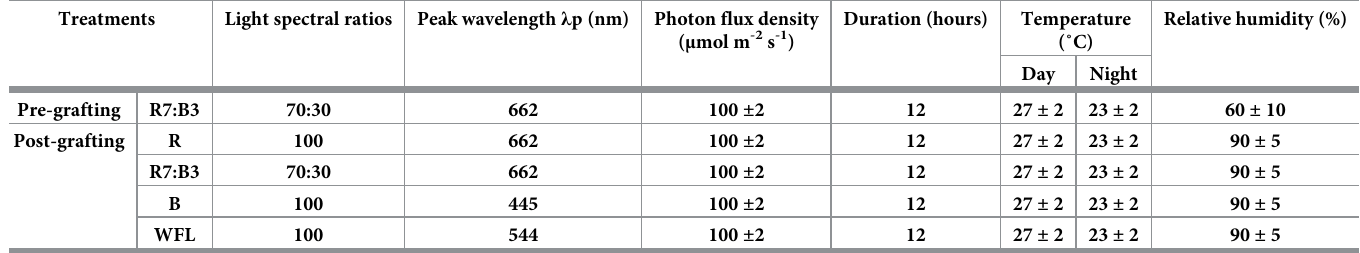
Table 1. Parameters of the LED light properties used in the study.